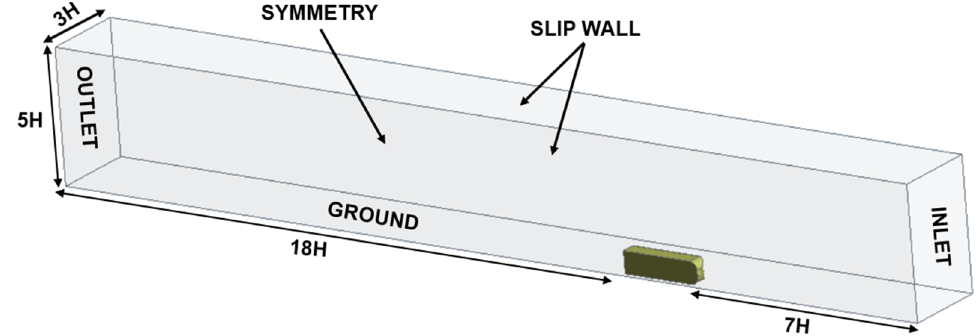
Figure 2. Computational domain and boundary conditions.